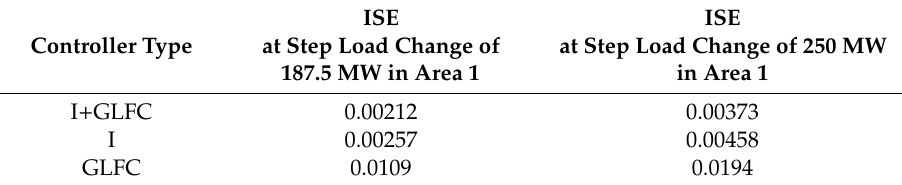
Table 4. The Performance index of ∆ f 2 .